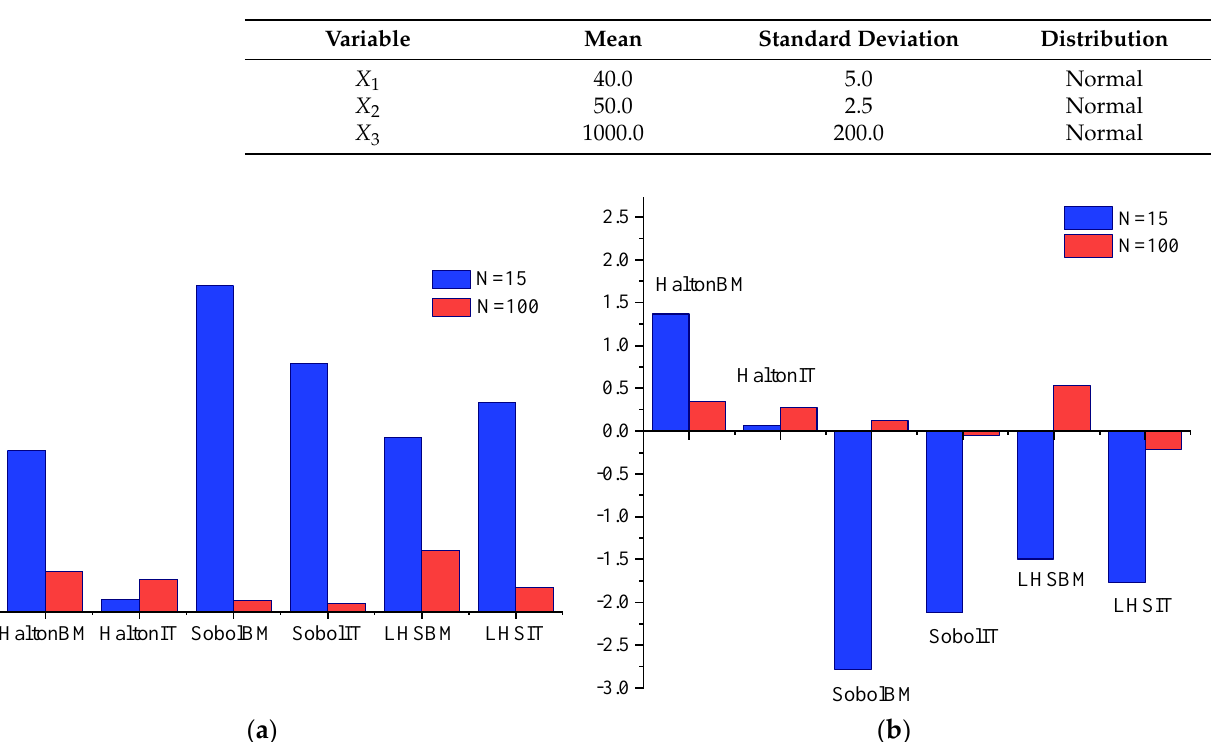
Table 1. Random variables and their parameters in Example 1.